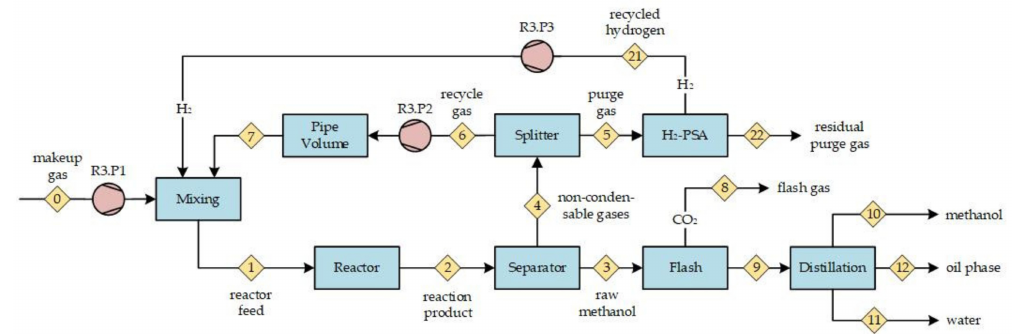
Figure 2. Flow scheme of the applied process